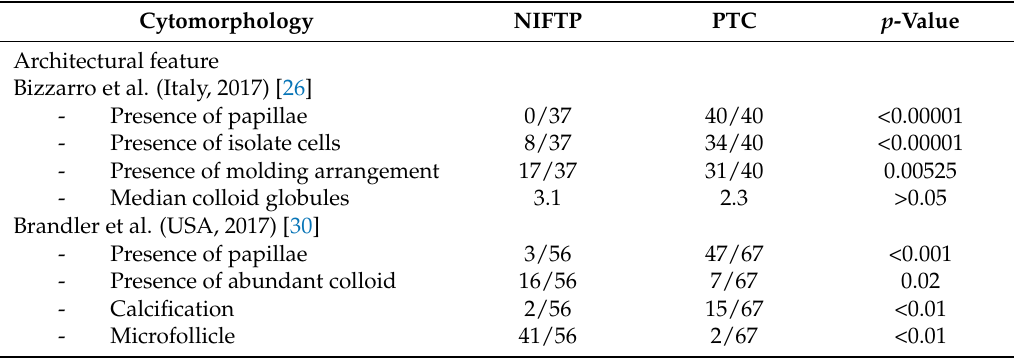
Table 2. Summary of the cytomorphological differences between NIFTP and classical papillary thyroid cancer